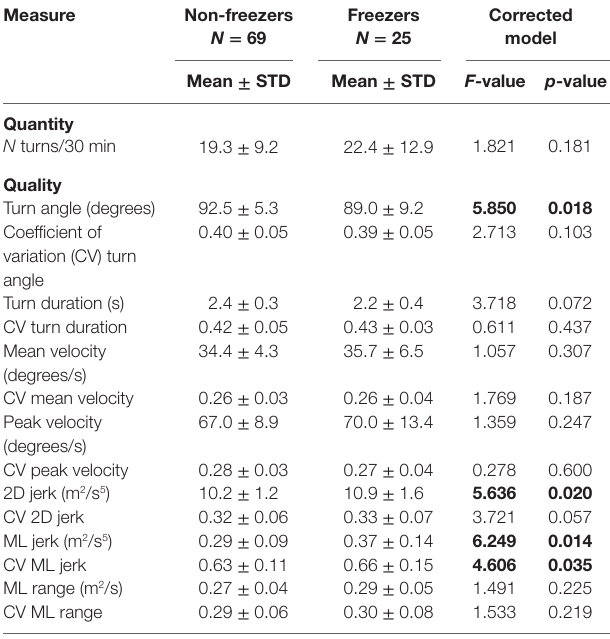
TaBle 2 | Three-day measures of quantity and quality of turning in non-freezers and